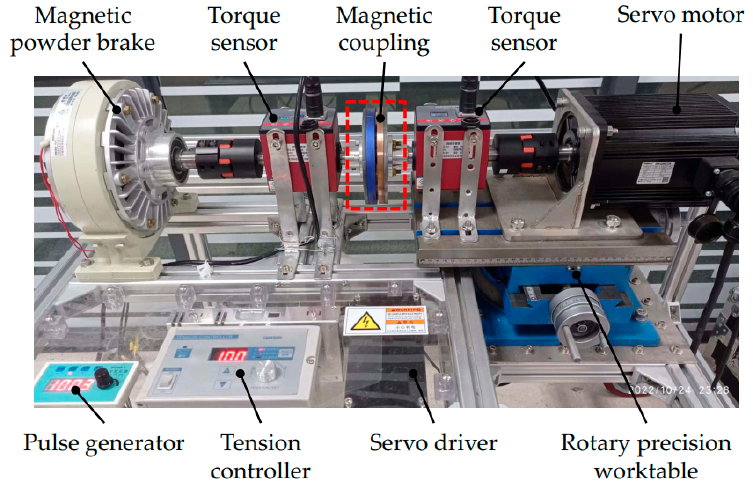
Figure 8. Principle prototype and test platform.